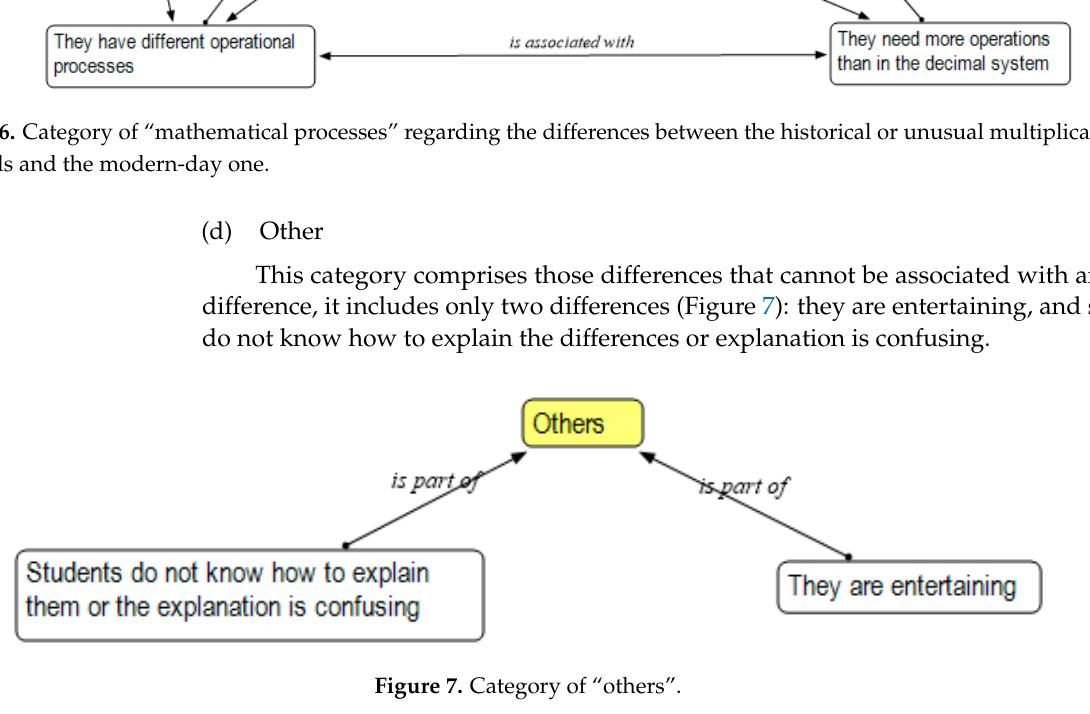
Figure 6. Category of “mathematical processes” regarding the differences between the historical or unusual multiplication methods and the modern-day one.